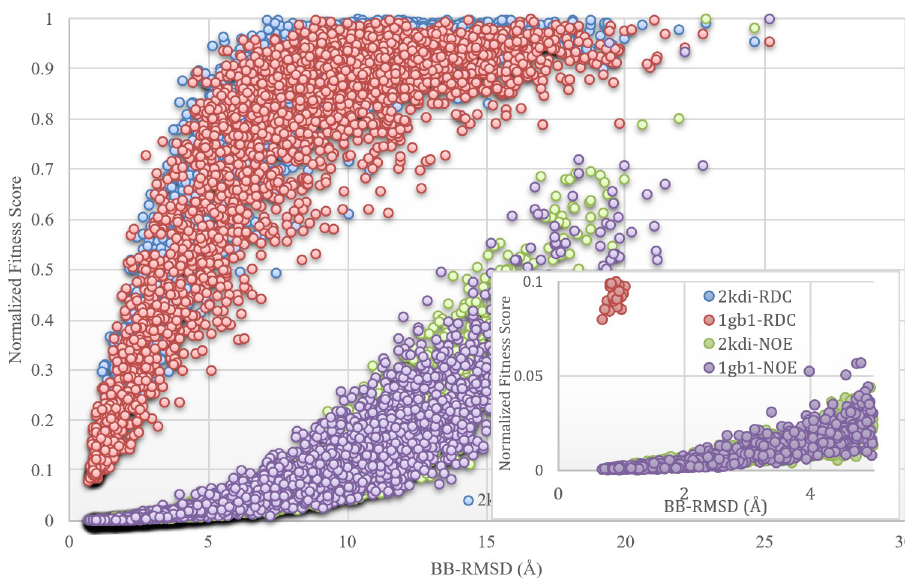
Fig 4. RDC and NOE fitness of 5000 decoy structures generated randomly from a known structure versus their BB-RMSD to the actual structure.